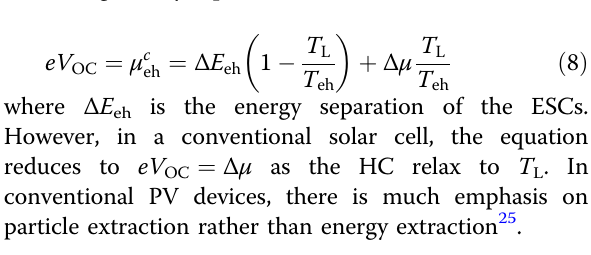
and μ c are the chemical potential energies e h is their separation. eh